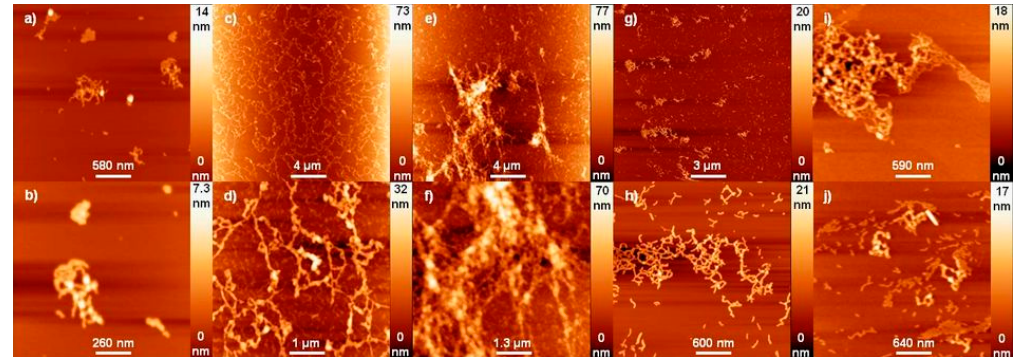
Figure 1. Atomic force microscopy (AFM) of porphyrin/PSS brush samples deposited onto a mica surface: ( a , b ) TAPP diacid-PSS brush sample with l = 0.4; ( c , d ) TMPyP diacid-PSS brush sample with l = 0.4; ( e , f ) TMPyP monoacid-PSS brush sample with l = 0.4; ( g , h ) TMPyP-PSS brush l = 0.5 in neutral solution; ( i , j ) Zn-TMPyP-PSS brush l = 0.4 in neutral solution.